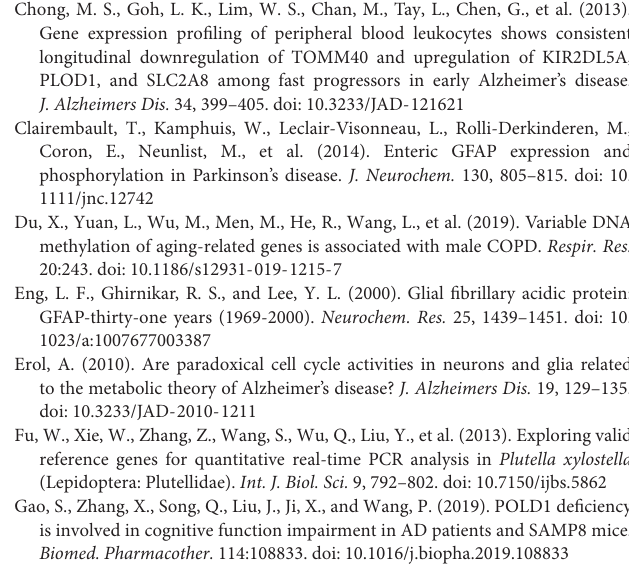
Supplementary Figure 1 | Gene set variation analysis showed the 20 up and down regulated biological processes in AD patients. Regulation of gluconeogenesis, positive regulation of Notch receptor target, and pyroptosis processes were upregulated in AD, while nervous system process and neuropeptide signaling pathway were downregulated. Supplementary Figure 2 | Checking the scale-free topology using soft-thresholds with β = 22. Supplementary Figure 3 | Scatterplots showed no significant relationship between the five hub ARDEGs and age. Significance level was denoted by ∗ p -value < 0.05, ∗∗ p -value < 0.01, ∗∗∗ p -value < 0.001. Supplementary Figure 4 | (A,B) Showed the expression levels of MAP4K4 and PDGFRB in different Braak stages, respectively. (C–H) Scatterplots show the significant relationship between hub ARDEGs and clinical characteristics. Significance level was denoted by ∗ p -value < 0.05, ∗∗ p -value < 0.01, ∗∗∗ p -value < 0.001. Supplementary Figure 5 | The Predicted microRNA (A) and transcription factors (B) for the selected five hub ARDEGs. The circular nodes represent the ARDEGs, and the square nodes represent miRNA (A) or transcription factors (B) , respectively. The size of a node depends on the degree of the